Question: Does the figure show an increasing or a decreasing trend?
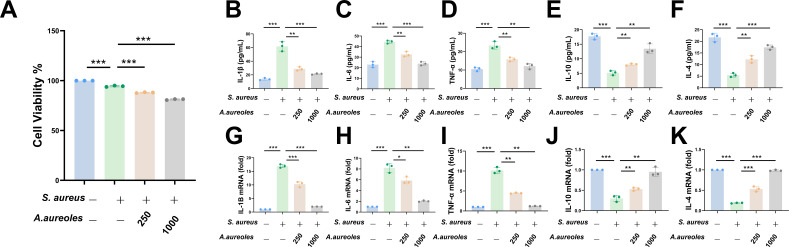
Answer: increasing